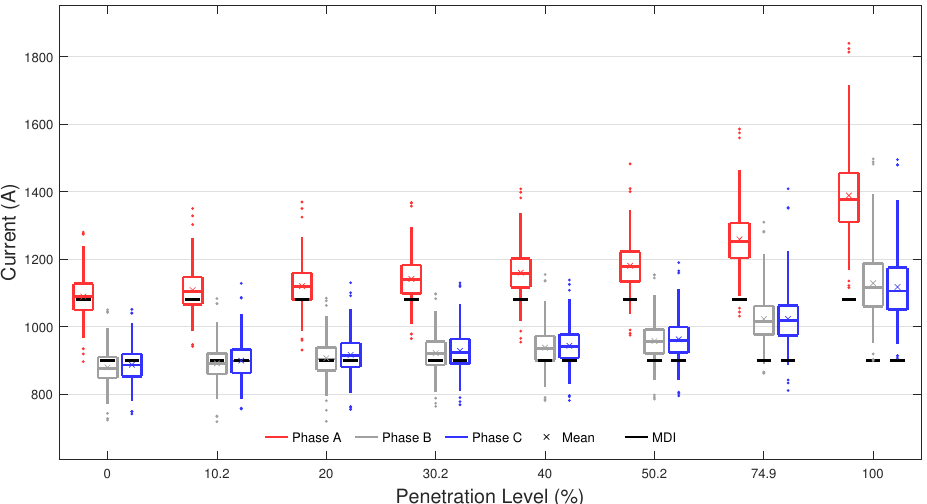
Figure 7. Distribution of maximum phase currents over all the scenarios for network #129 as a function of EV penetration.